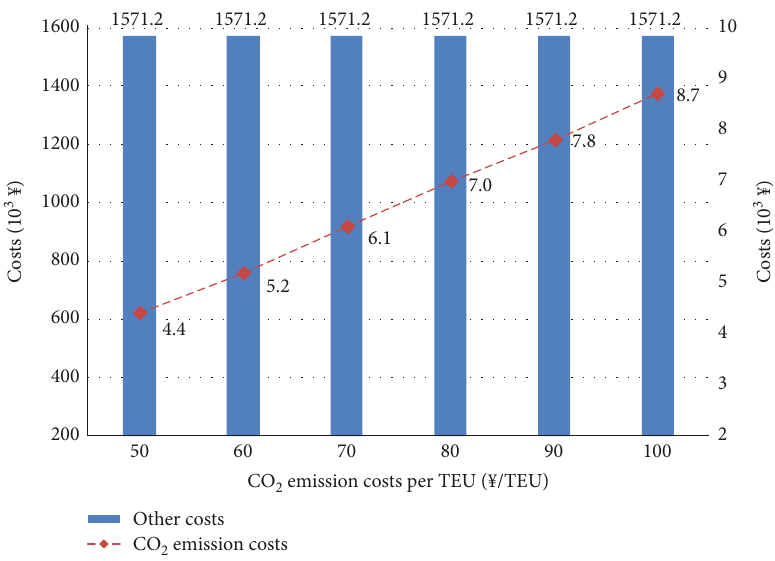
Figure 7: Sensitivity of the multimodal routing with respect to the CO